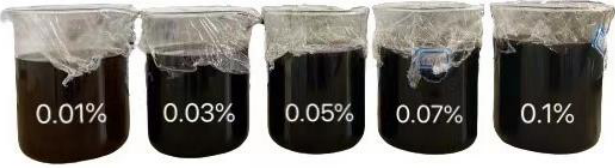
Figure 4. GO dispersion.